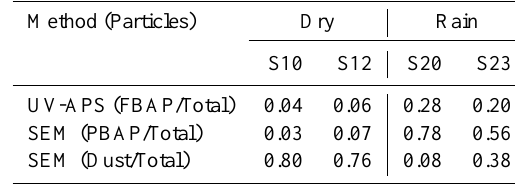
Table 1. Number fraction of biological particles and mineral dust particles in aerosol samples collected during dry periods and rain events. The sample numbers S10, S12, S20, S23 re- fer to Nuclepore ® filters analyzed by SEM (details specified in Sect. S1.4.1.3). The UV-APS data were averaged over periods matching the filter sample collection times. Fluorescent biologi- cal aerosol particles (FBAP), primary biological aerosol